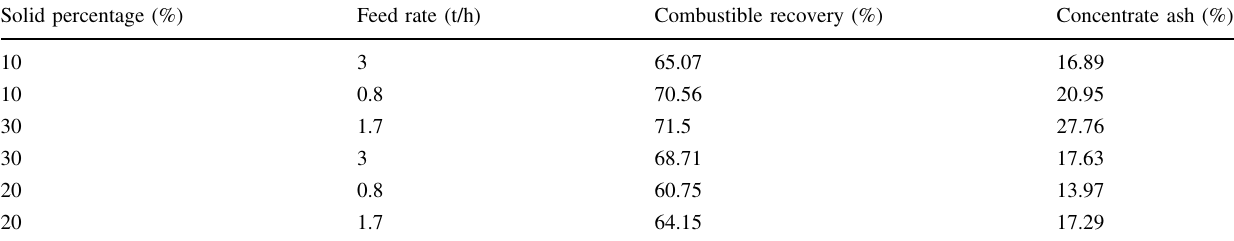
Table 5 Spiral tests and their representative results Solid percentage (%)